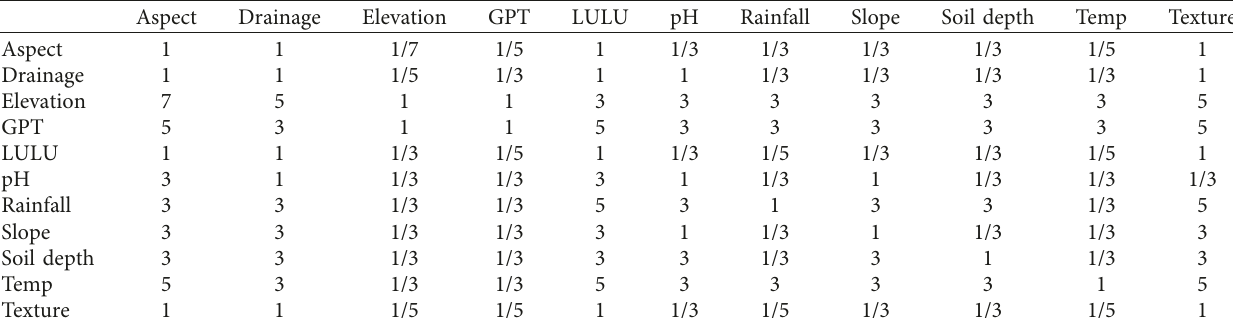
Table 1: Pairwise comparison matrix of the criteria and their weights.